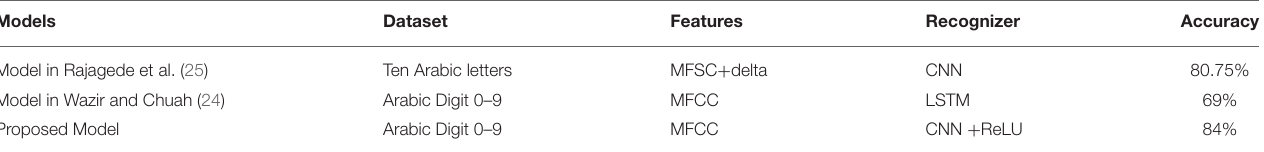
TABLE 2 | Comparison of